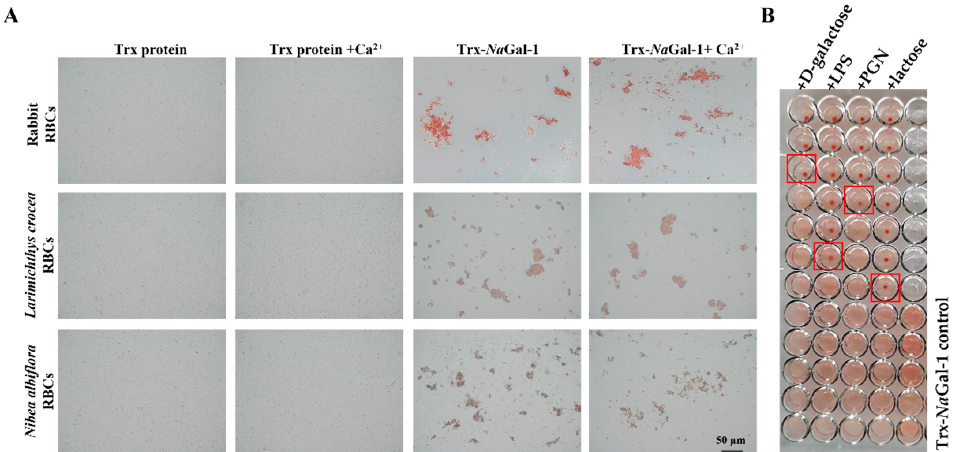
Figure 7. Hemagglutination and sugar inhibition assay of Trx ‐ Na Gal ‐ 1 protein. ( A ) Hemagglutination of Trx ‐ Na Gal ‐ 1 protein toward RBCs from rabbit, L. crocea , and N. albiflora , the Trx protein groups were as negative control. ( B ) The red boxes indicate the minimum inhibitory concentration of sugars (From top to bottom are corresponding to high ‐ to ‐ low concentrations of competitive sugars: the initial concentration of PGN and LPS are 12.22 ng/mL, the initial concentration of D ‐ galactose and lactose are 39.06 μ g/mL, and then two ‐ fold serial dilutions are made from top to bottom), the minimum inhibitory concentrations of Trx ‐ Na Gal ‐ 1 protein to LPS, PGN, lactose, and D ‐ galactose were 0.38 ng/mL, 1.52 ng/mL, 2.44 μ g/mL, and 19.53 μ g/mL, respectively. This assay was performed in triplicates.